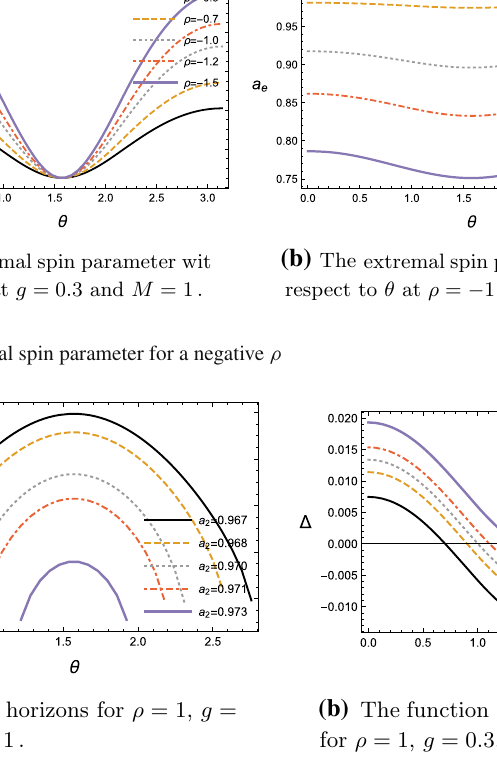
function Δ in the θ direction for ρ = 1, g = 0 . 3, and M = 1 .